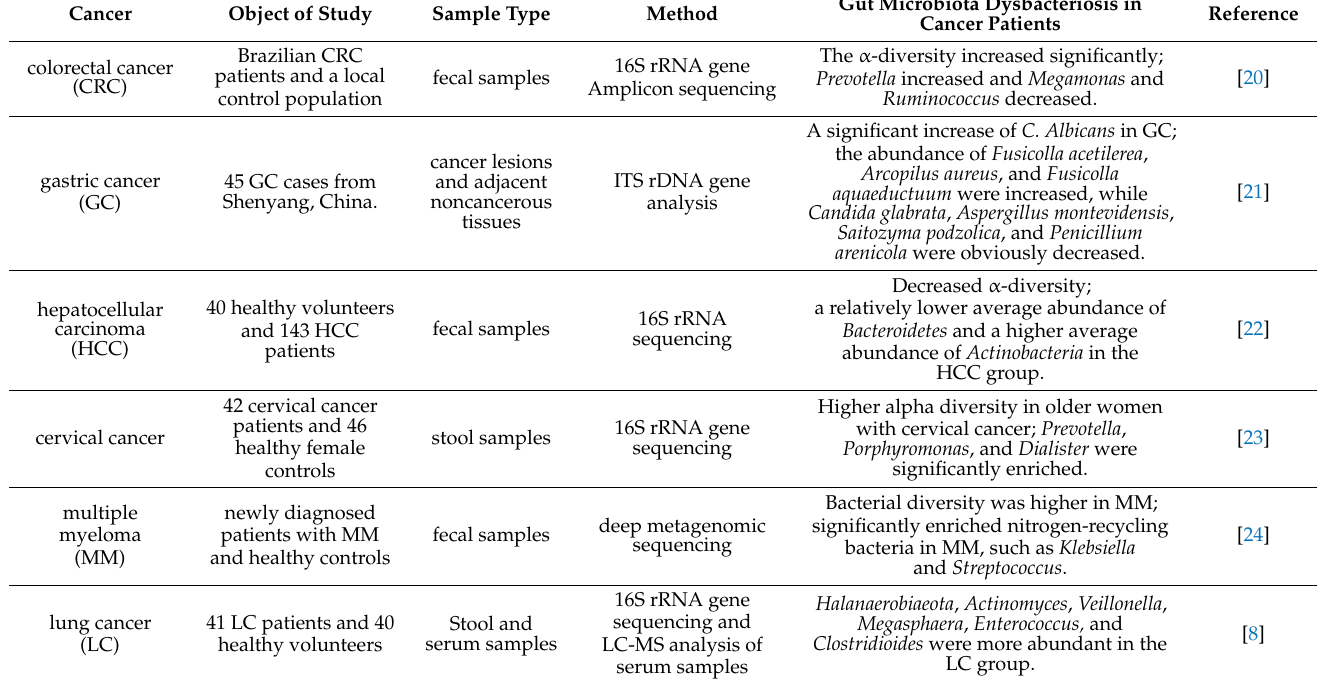
Table 1. Dysbiosis of gut microbiota in the development and progression of